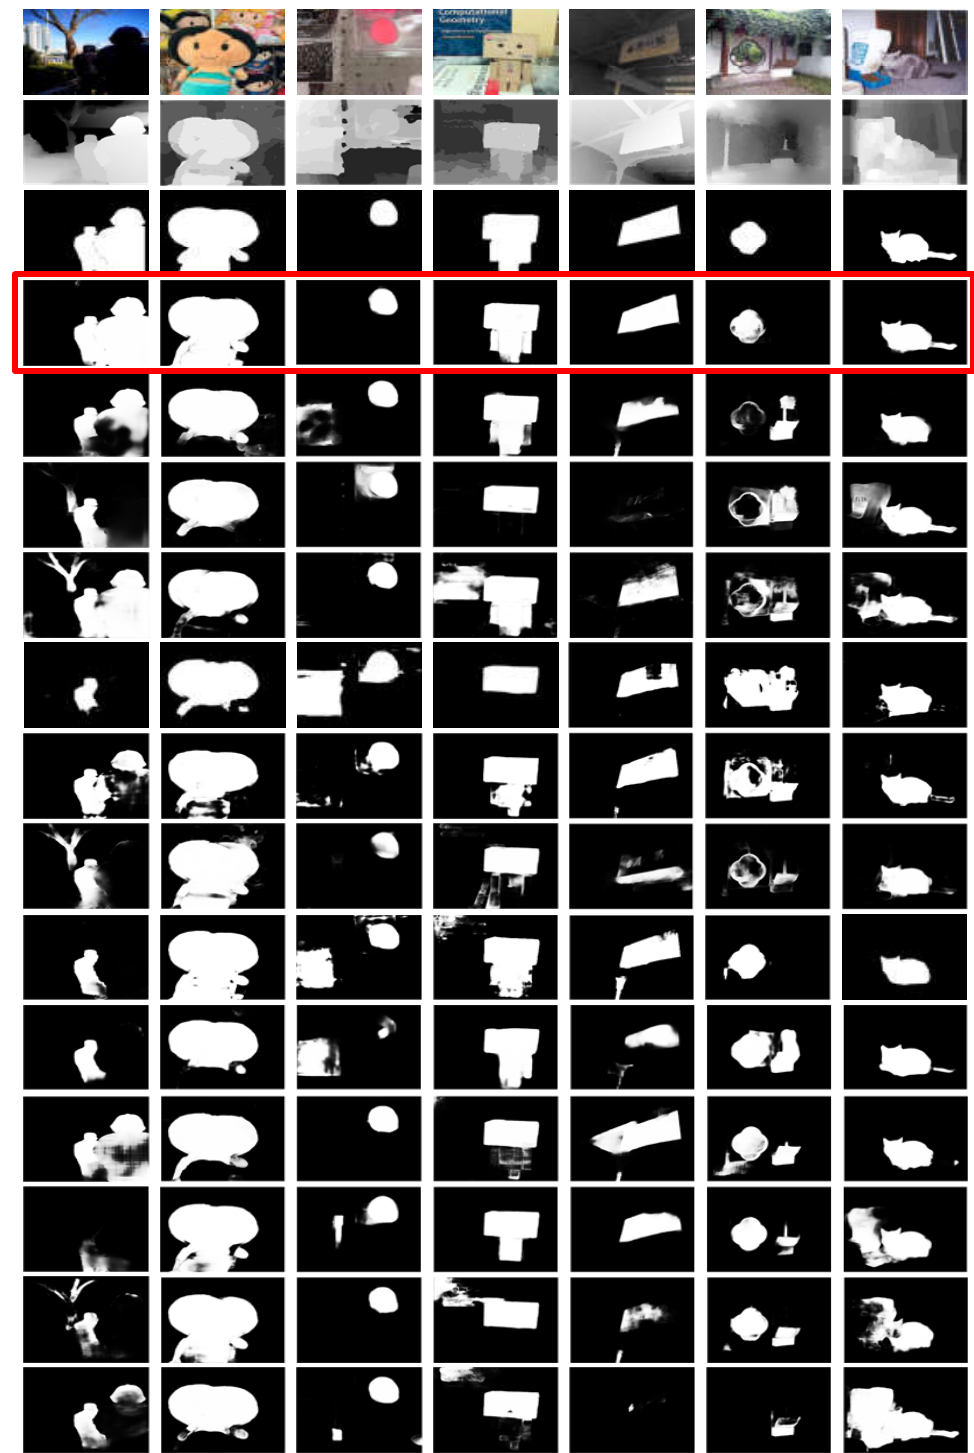
Figure 5. Visual examples of our method and the evaluated algorithms. From top to bottom: RGB image, depth image, GT, DIN (ours), DANet [36], PGAR [61], CMWNet [62], ATSA [19], D3Net [55], DSA2F [20], DCF [63], HAINet [64], CDNet [65], CDINet [66], and SSP